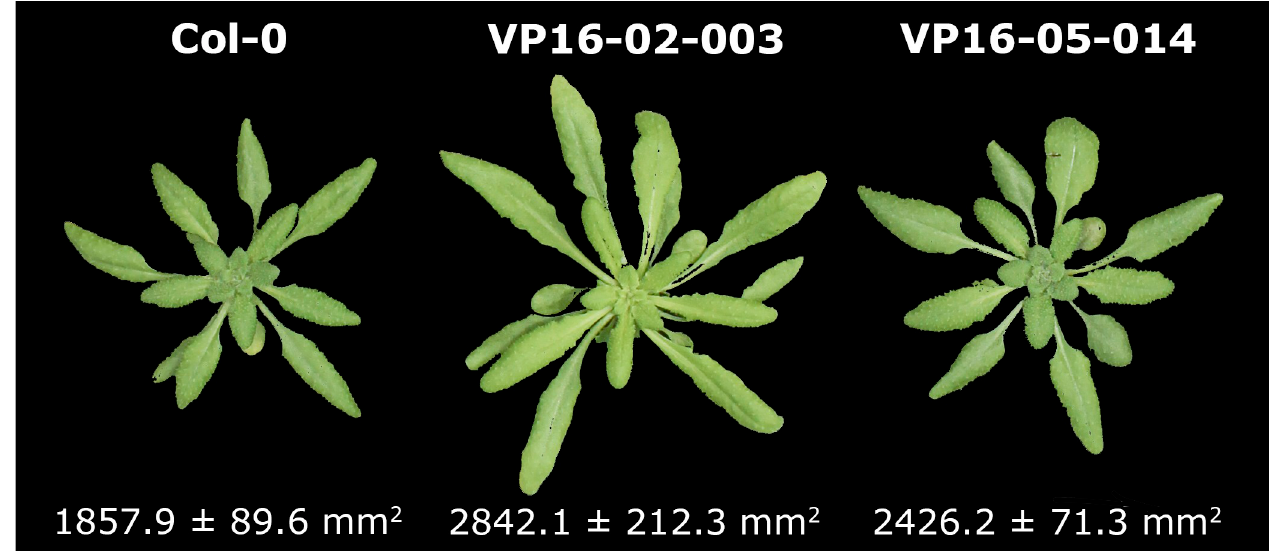
Fig 1. Representative overview of the rosette phenotypes of Arabidopsis Col-0, VP16-02-003 and VP16-05-014 at 28 days post germination. Data of average rosette surface area is shown below each images as mean ± SEM (n = 18).